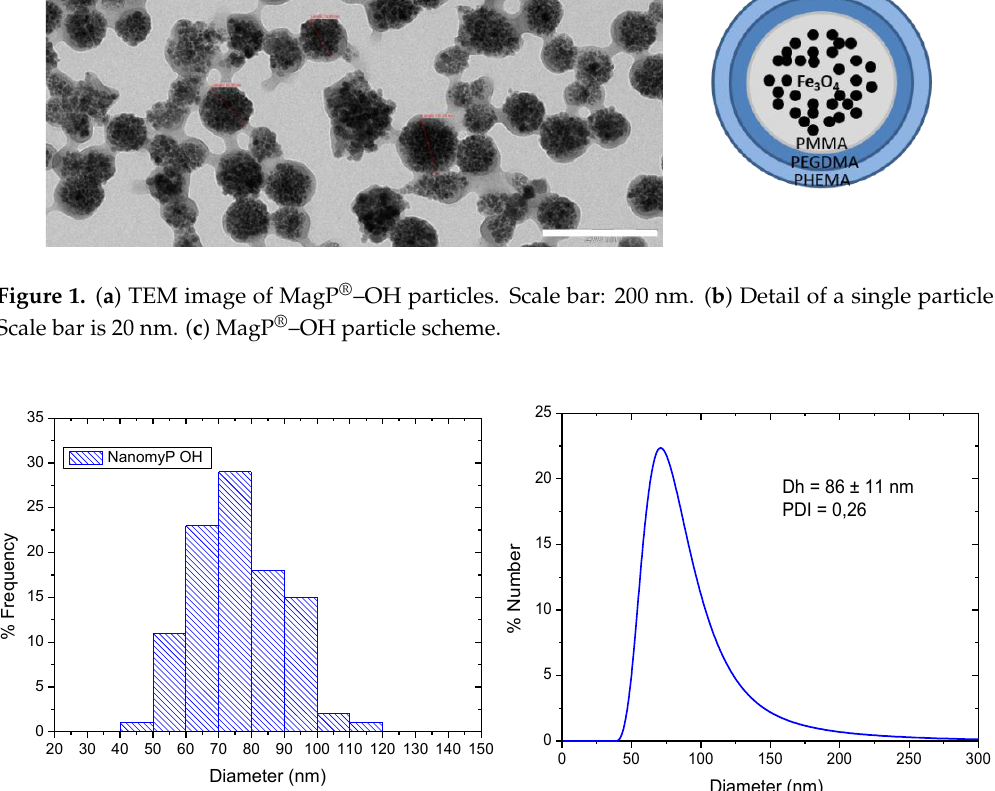
Figure 2. Left: Diameter histogram of the MagP ® – OH particles calculated from TEM images. Right: size distribution by number, calculated from DLS data.